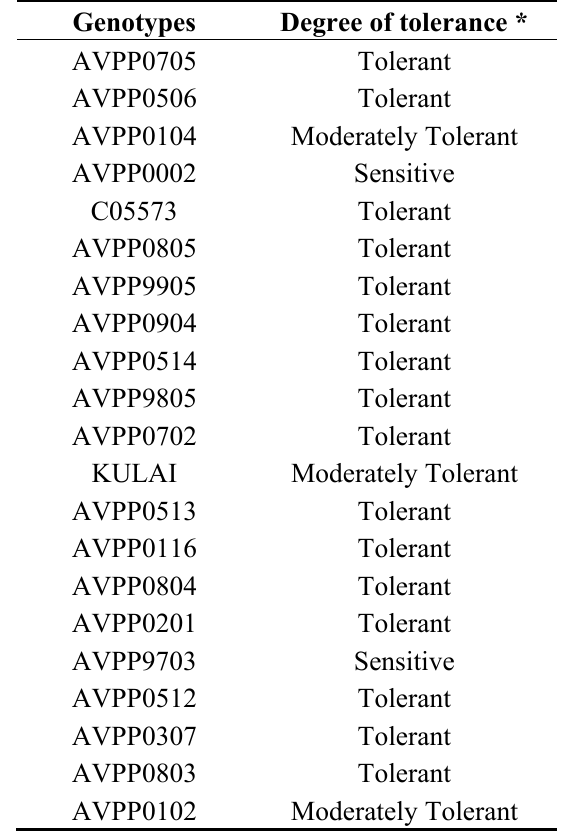
Table 7. Genotypes and their degree of heat